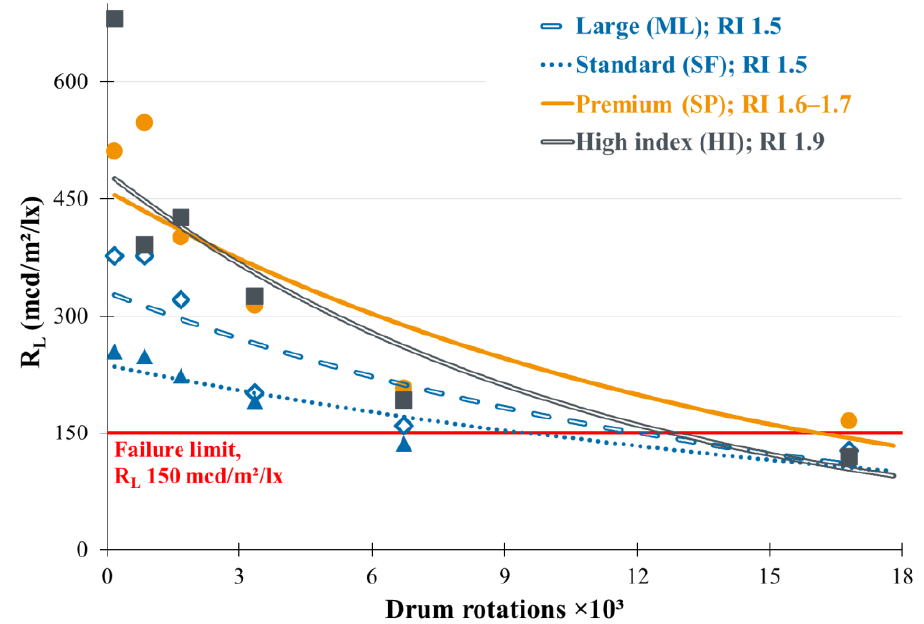
Figure 2. Loss of R L under abrasive testing.